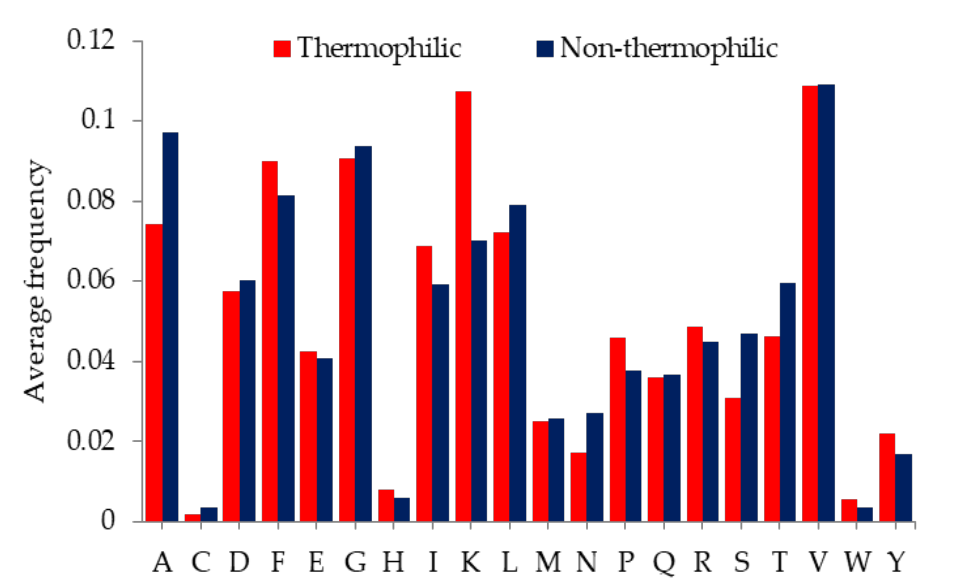
Figure 1. The average frequencies of amino acids in thermophilic proteins and their non-thermophilic